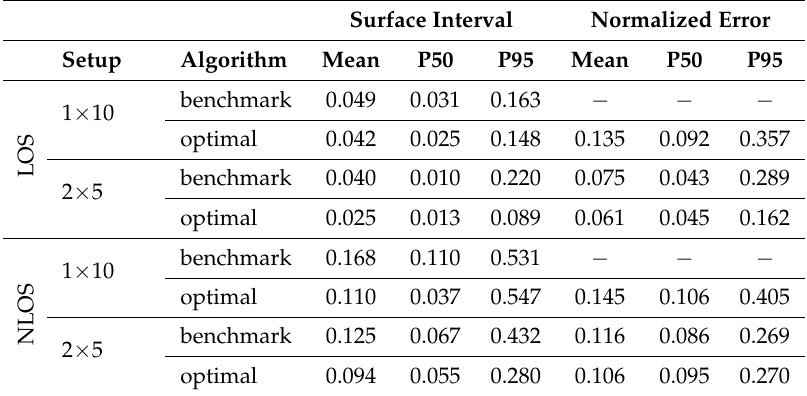
Table 1. Comparison of one 10-element array with two 5-element arrays in test setup TS brick